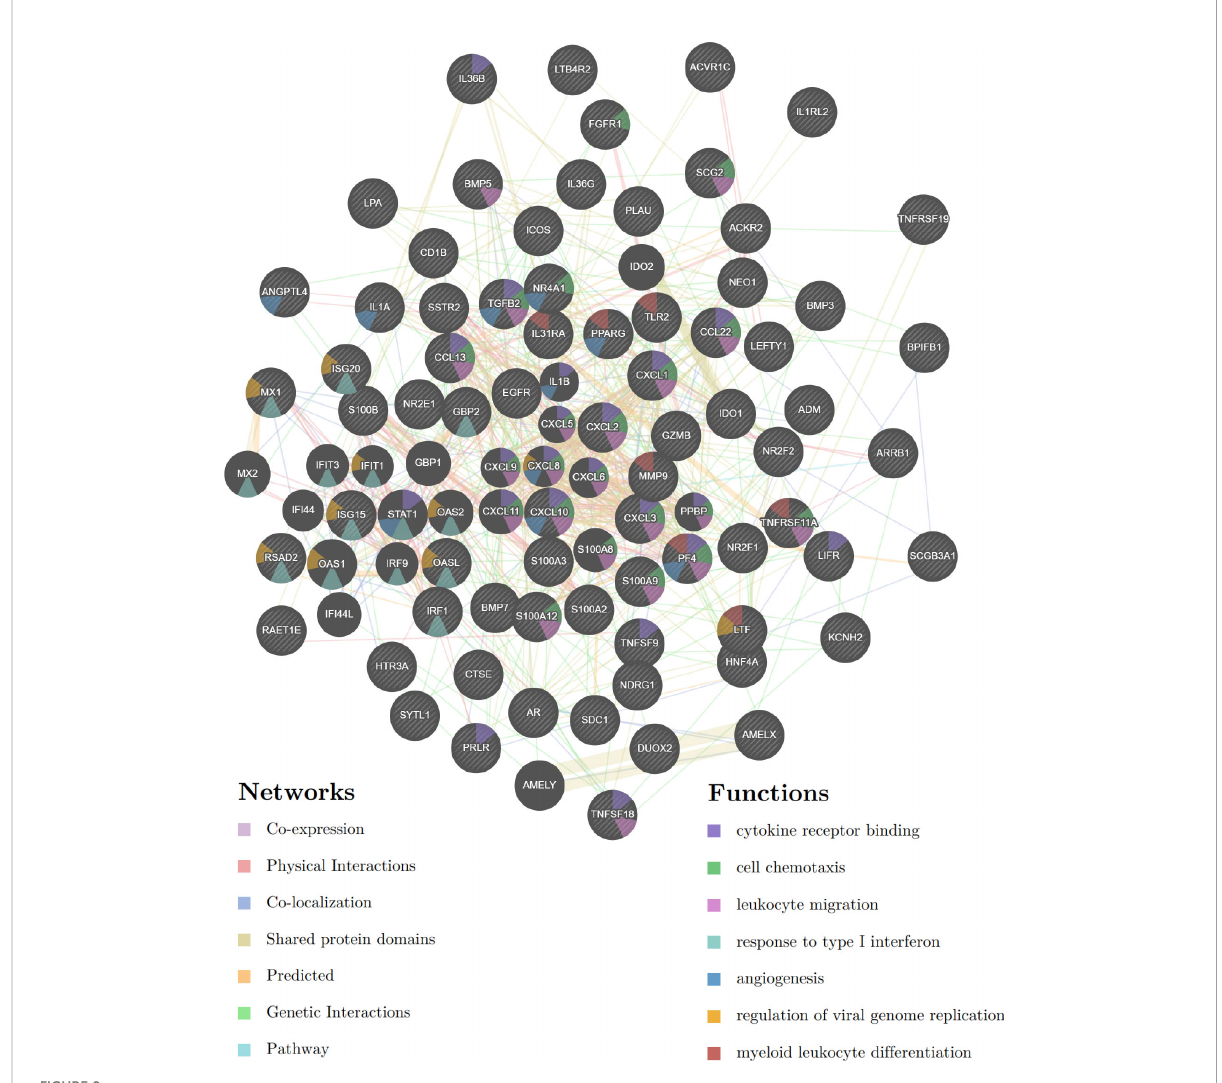
FIGURE 9 Protein-protein interaction network based on the E6 splicing immune-related ceRNA networks in the TCGA-CESC